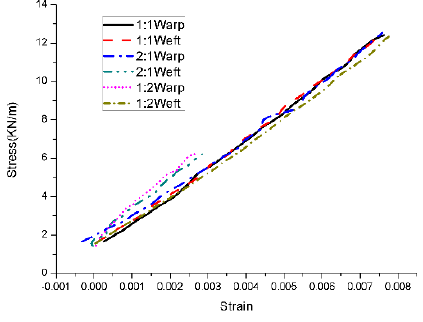
Figure 10. Stress-strain curves.